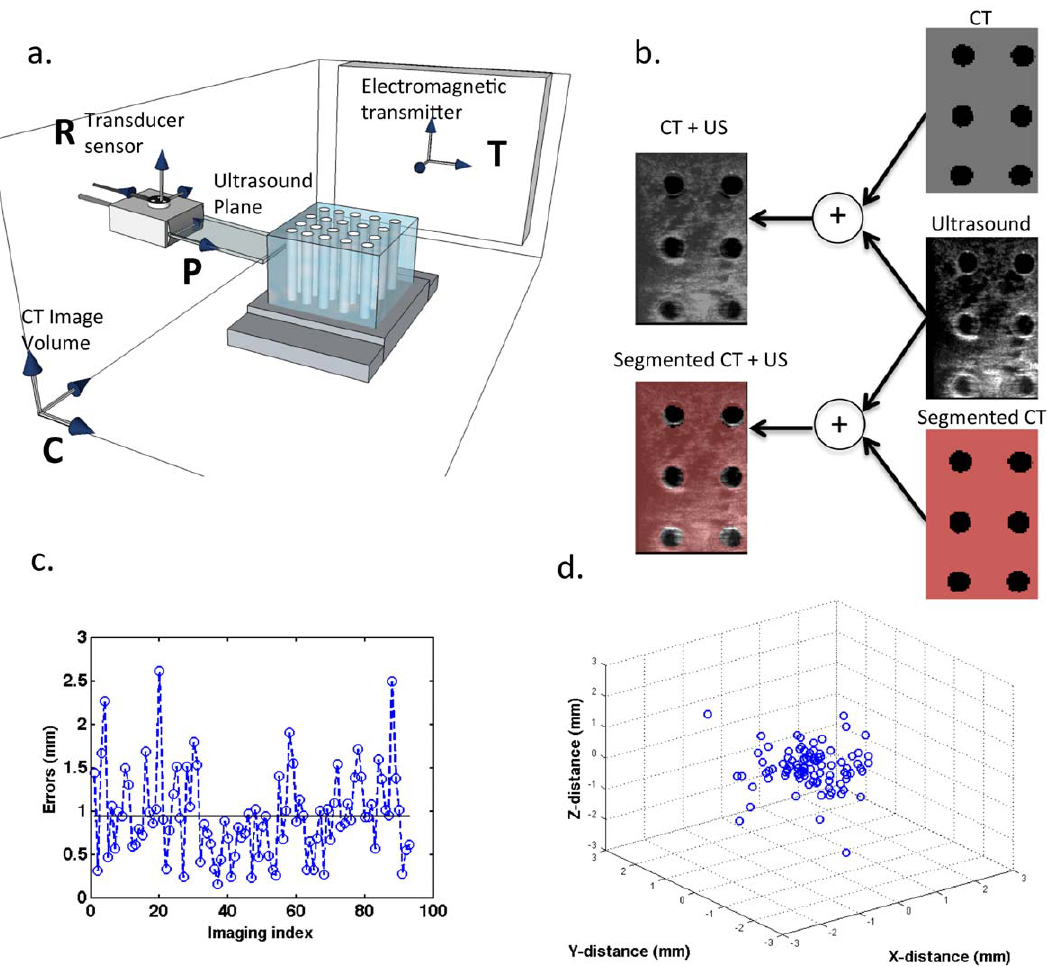
Figure 1. Calibration and accuracy of electromagnetically-tracked CT/US. (a) Relevant hardware for combined CT/US with the coordinate systems used to join the tracked US transducer and CT image space. The US plane, P space, is calibrated with respect to a position sensor, R space, attached to the US transducer. The sensor’s location is known relative to an electromagnetic transmitter, T space, whose orientation relative to the CT image space, C , is determined by fiducial registration. (b) The combined imaging system is used to view B-mode US, the corresponding CT slice, the corresponding segmented CT slice, or any combination of these slices in real-time. (c) The magnitude of the error in calibration across 93 observations of a single point imaged from multiple angles with a mean of , 0.94 6 0.5 mm. (d) Calibration data from (c) plotted in 3D to provide the spatial distribution of the error and indicate that the error is isotropic.